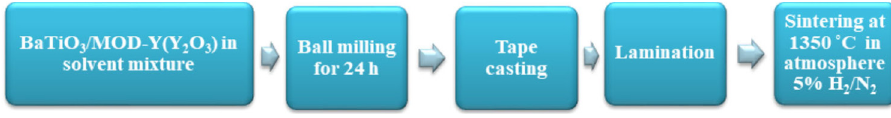
Figure 7. BaTiO 3 modification process.